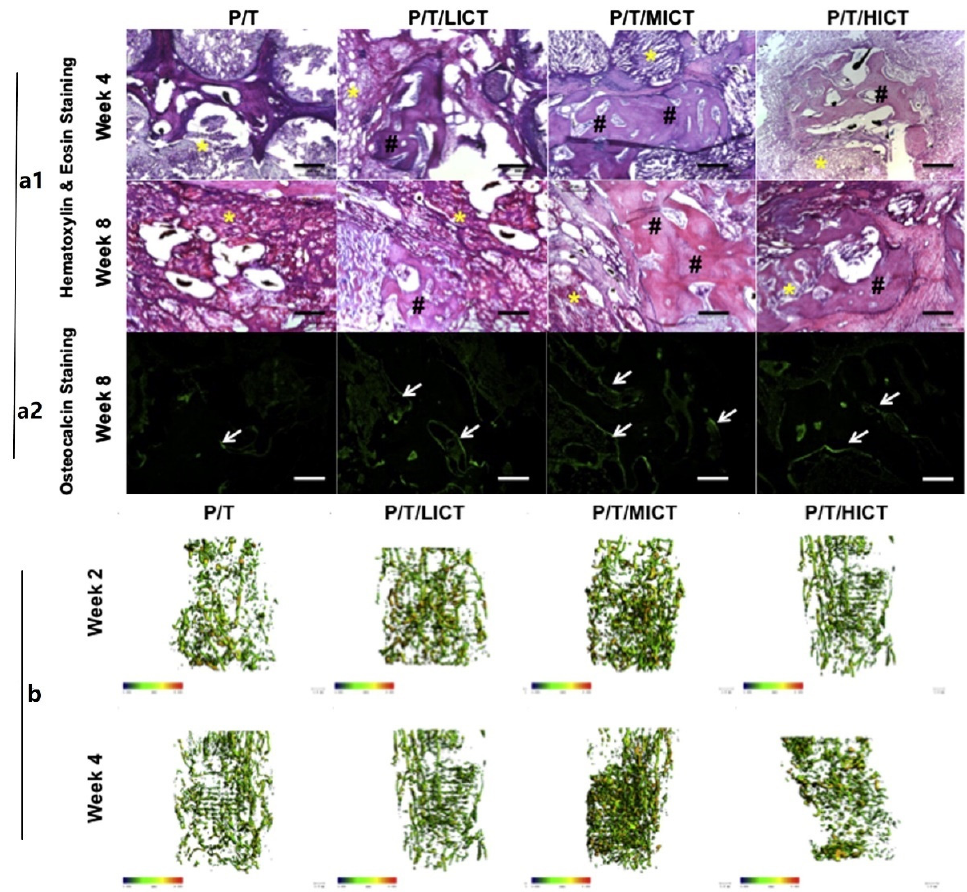
Figure 4. Icariin can effectively improve osteogenesis and angiogenesis. ( a1 ) Sagittal section of decalcified bone defect with H&E staining (yellow *, scaffold; black #, new bone; black or white bar = 200 µ m), ( a2 ) Representative immunohistochemistry of osteocalcin expression in osteoblasts and mineralized sites ( b ) Representative micro-CT-based microangiography of vessels formed within the ulnar seg- mental defect region at weeks 2 and 4 after implantation, Reprinted with permission from ref.